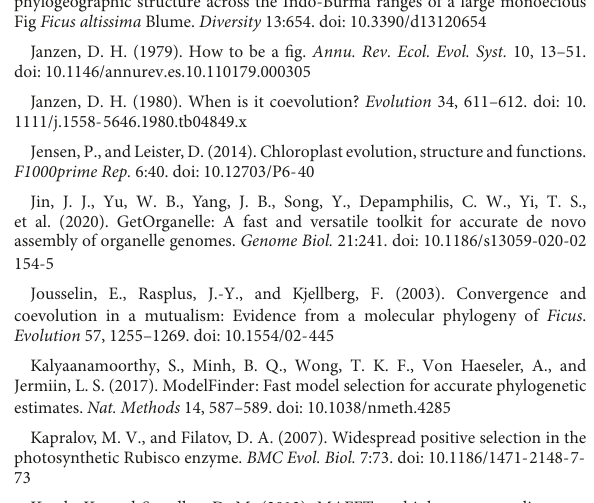
Fig Ficus altissima Blume. Diversity 13:654. doi: